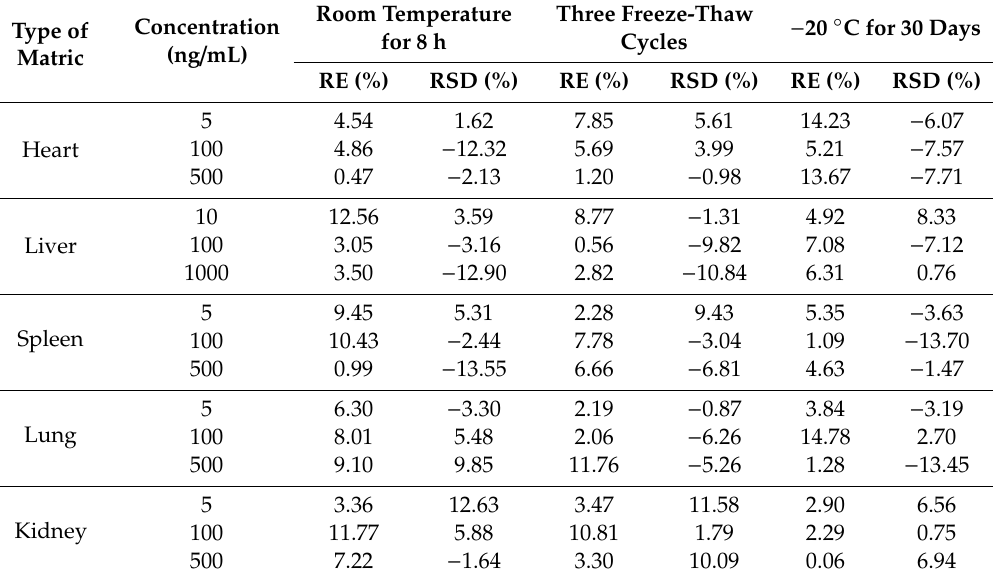
Table 3. Stability of HCPT in tissue under various storage conditions (n =